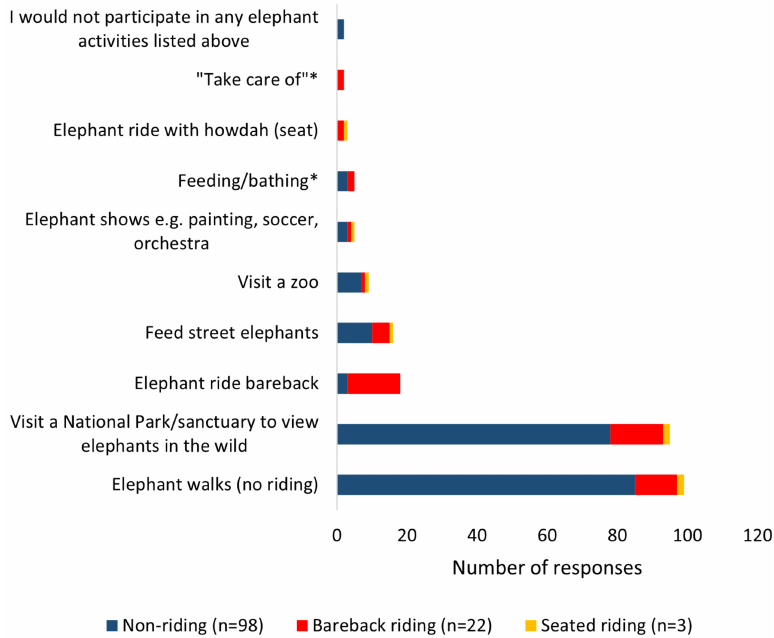
Figure 3. Respondent preferences for elephant-related activities per venue type. ’*’ Denotes themes constructed from participants’ responses, all others were reasons included in the questionnaire. Total of 254 activities were stated (participants could give >1 activity).